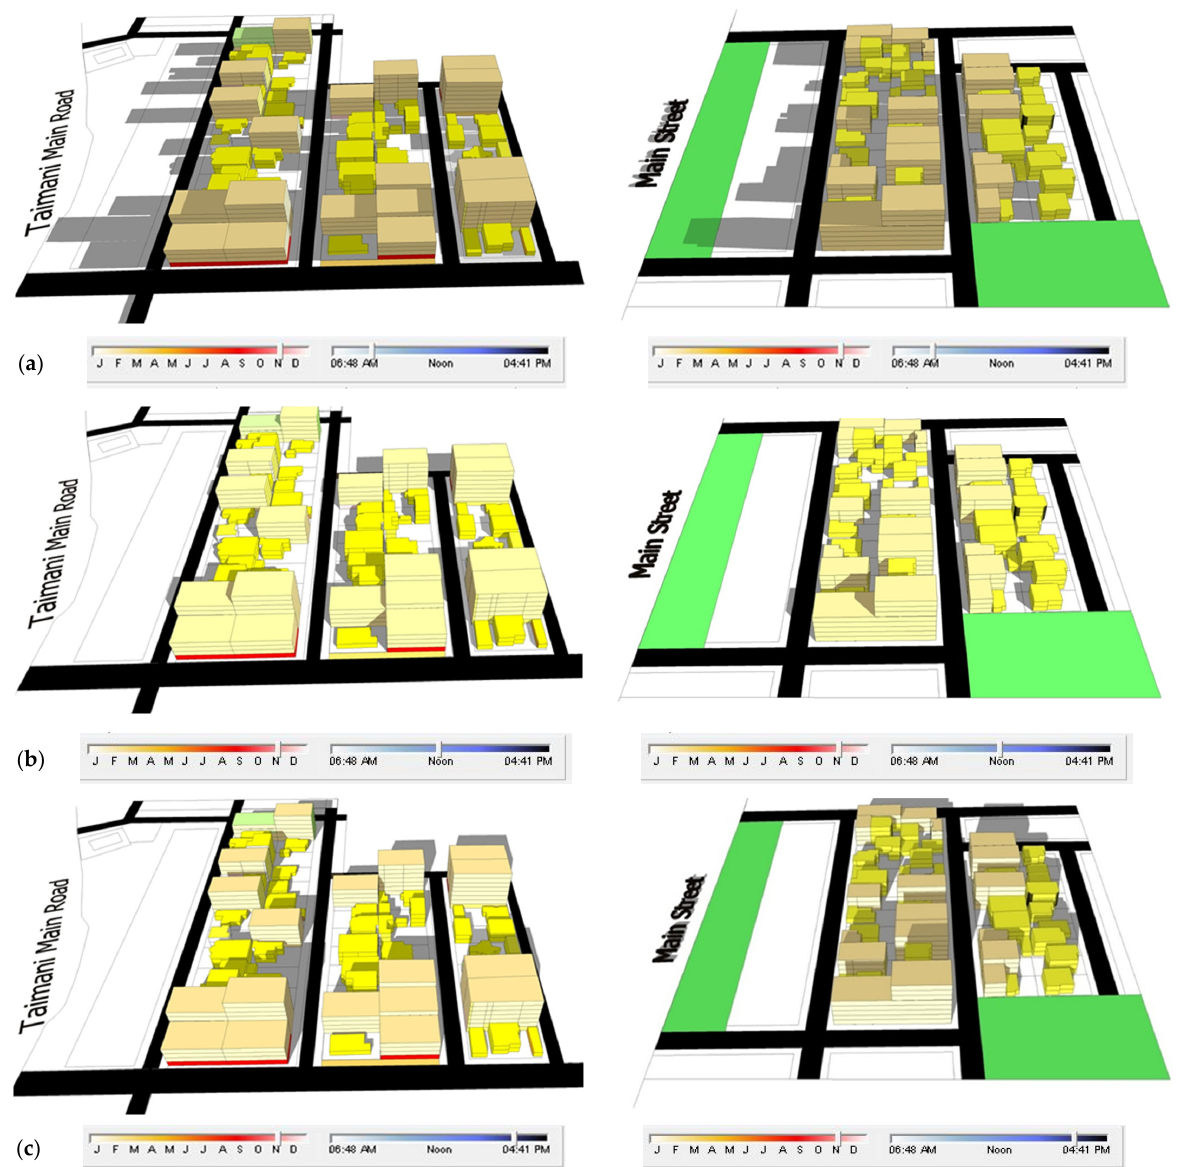
Figure 8. Shadow impact analysis projection of study areas: ( a ) morning times; ( b ) noon times; ( c ) afternoon times.